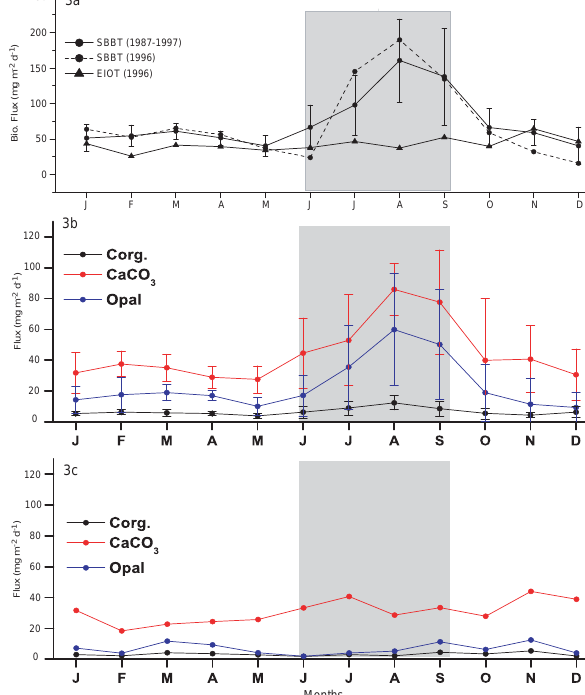
Fig. 3. Monthly mean climatology (1987–1997) of biogenic flux (mgm − 2 d − 1 ) at SBBT (solid line with filled circle) and monthly mean biogenic flux for the year 1996 at SBBT (broken line with filled circles) and EIOT (filled triangle). (b) and (c) represent com- ponent fluxes (red line-calcium carbonate; blue line-Opal; black line-organic carbon) at SBBT and EIOT respectively. Shading rep- resents the summer monsoon period (June–September) and vertical lines are one standard